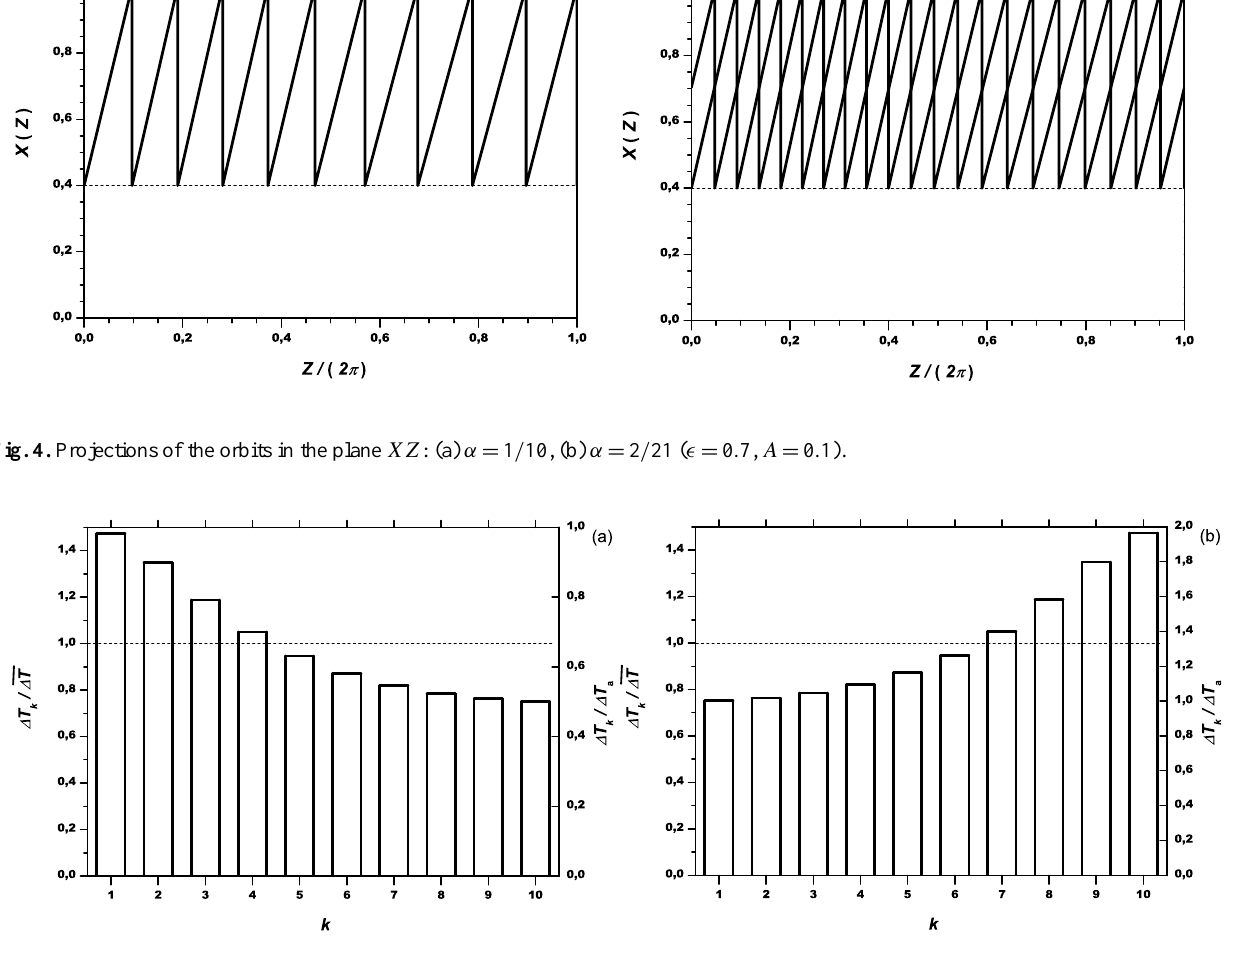
Eq. (23), where X 0 = 0 . 4. We choose A = 0 . 1 for the ampli- tude of strain rate